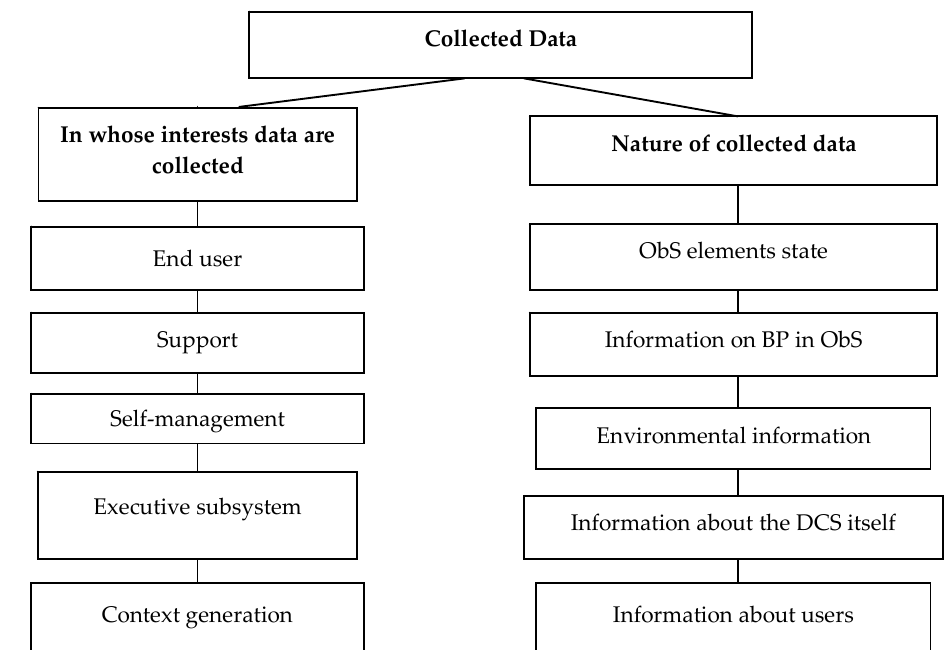
Figure 2. Classification of data collected in AmIS. Table 1. Key stakeholders and their